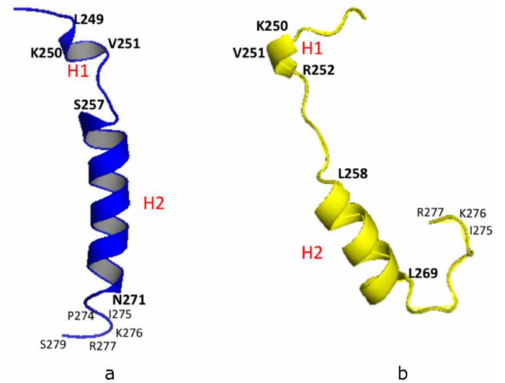
Figure 2. 3-D structural backbone models of PSTD in ST8Sia IV, based on NMR spectroscopy ( a ), and the Phyre2 server ( b ). The short helix and the long helix are labeled H1 and H2,